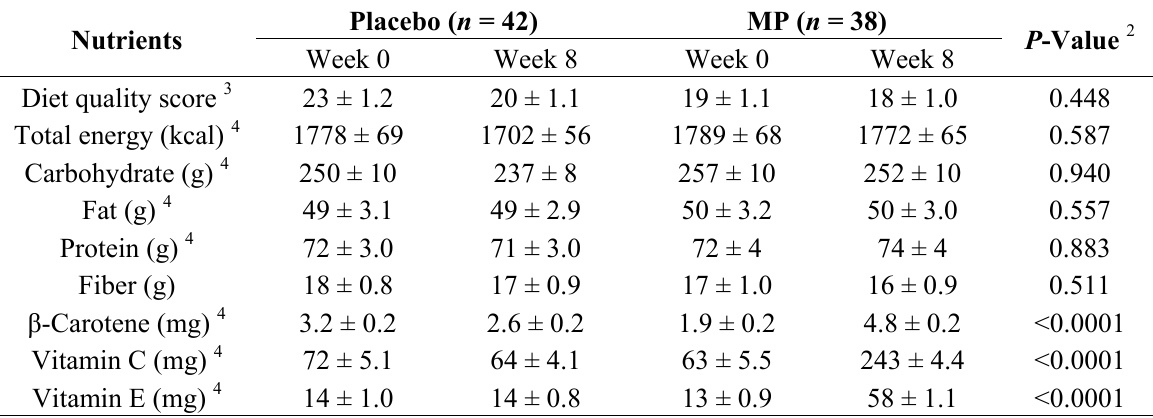
Table 2. Nutritional composition of the subjects’ diets throughout the study period 1